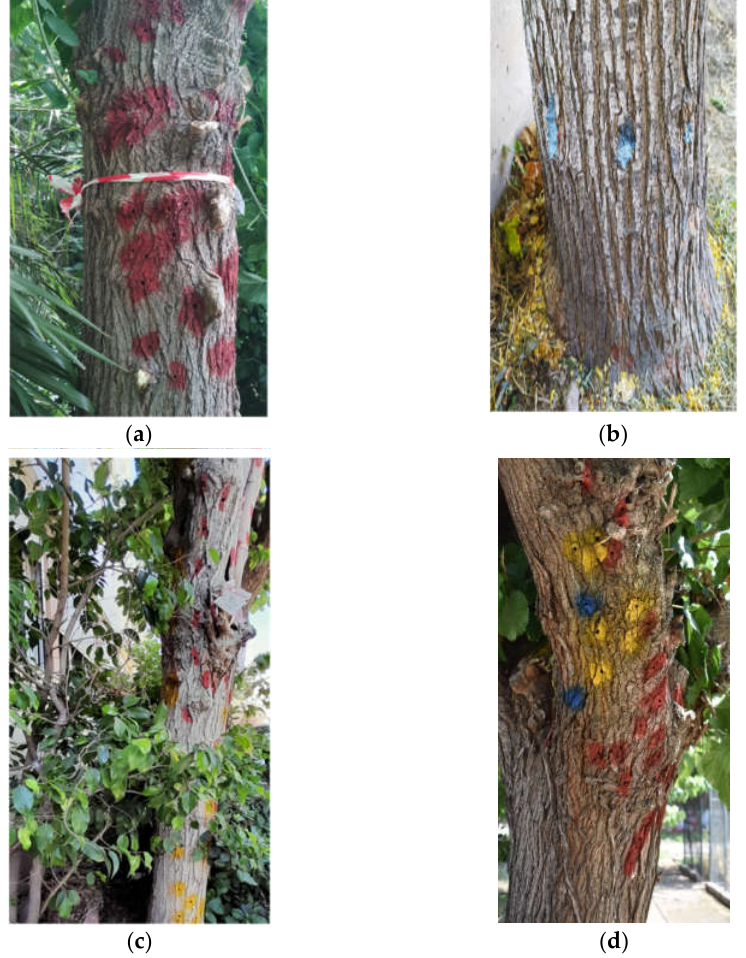
Figure 1. ( a ) Marked exit holes of X. chinensis before the application of trunk injection, in 2020. ( b ) Injection holes covered with inoculation paste; ( c ) Exit holes of X. chinensis before (marked in red, 2020) and after trunk injection (marked in yellow, 2021); ( d ) Exit holes of X. chinensis during the entire experimental period, i.e., with red exit holes before the injection of insecticides (2020), with yellow exit holes after the first application of trunk injection (2021); with blue exit holes after the second application of the method (2022).